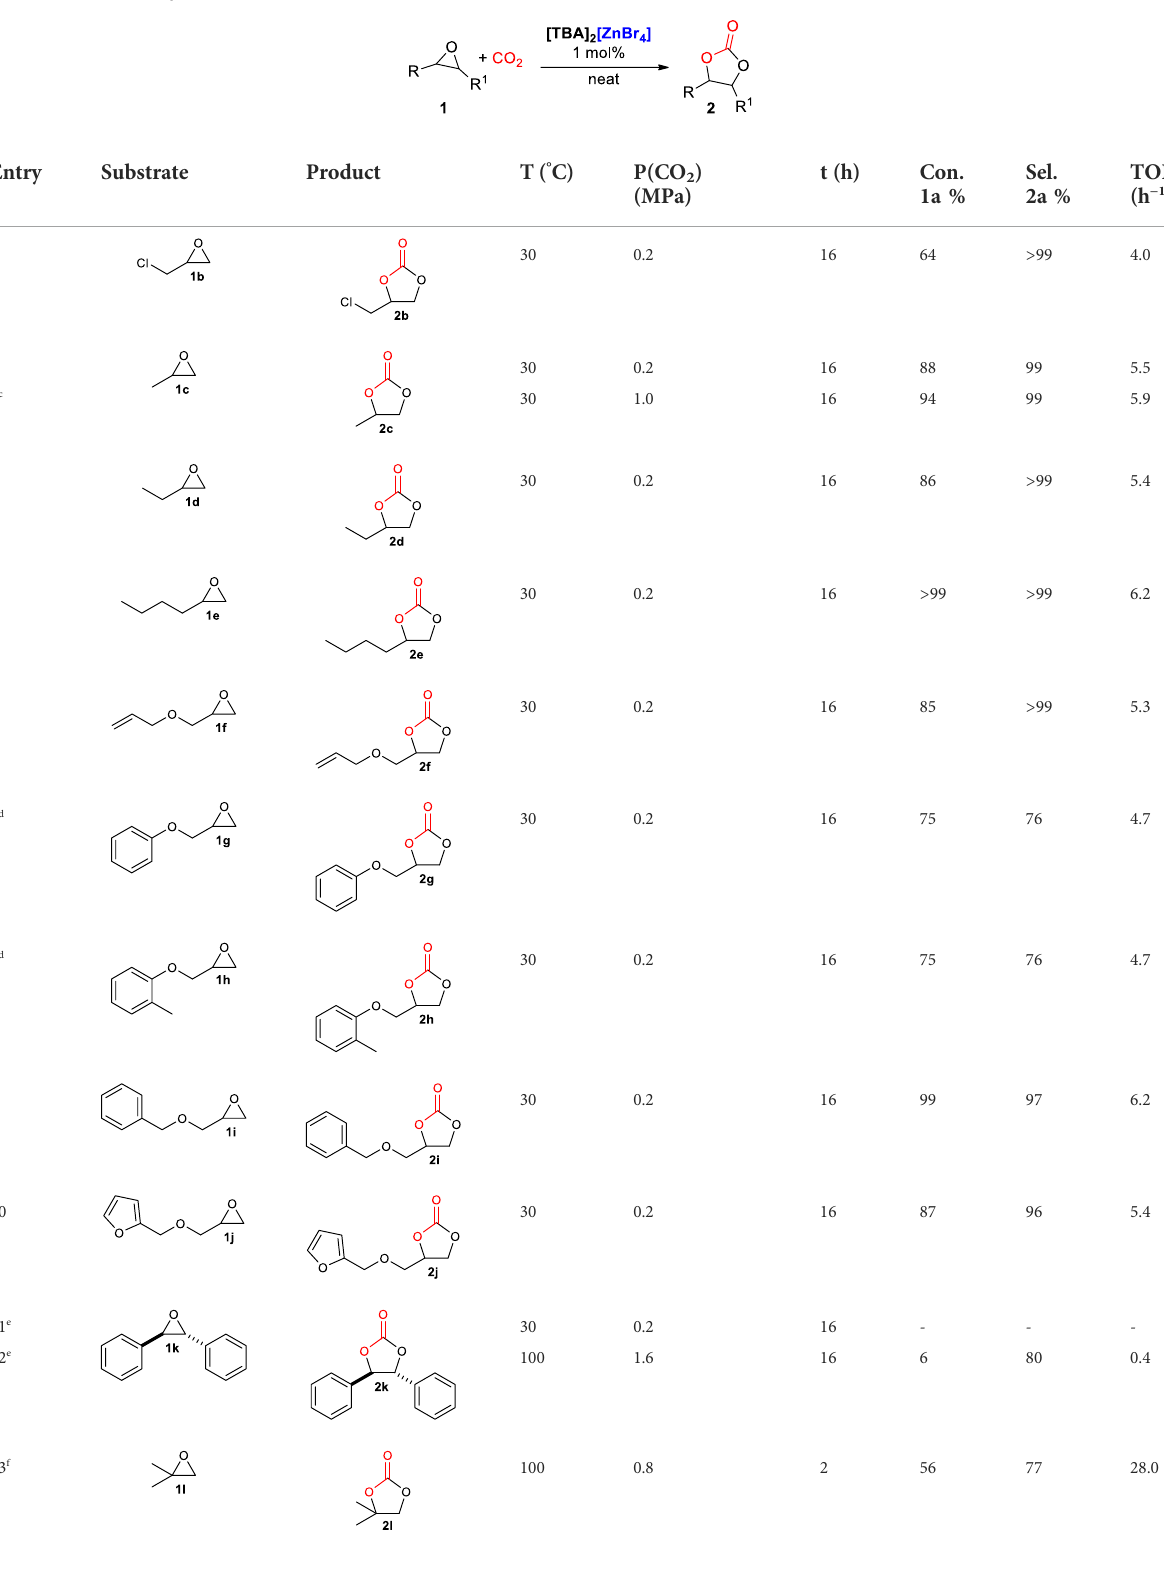
TABLE 5 Reaction scope a